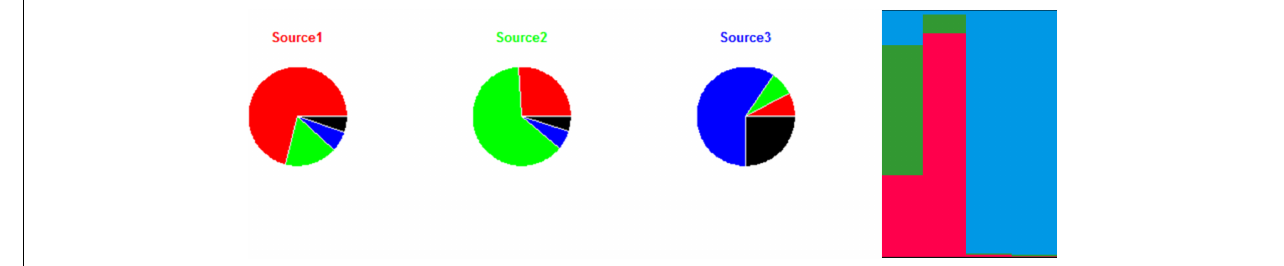
FIGURE 4 | Illustration of the approach for source attribution of the asymmetric island model. Pie charts: migration rate (segments with colors different from the source name) and mutation (black segments) for each of the three sources according to the allelic frequencies of the sources shown in Figure 3 . Bar chart: attribution probabilities of the four human strains for the three sources (source 1 in red, source 2 in green and source 3 in blue) estimated by the asymmetric island model according to the allelic profiles presented in Figure 3 . Each vertical bar represents a strain. The relative lengths of the color bars for a strain are proportional to their attribution